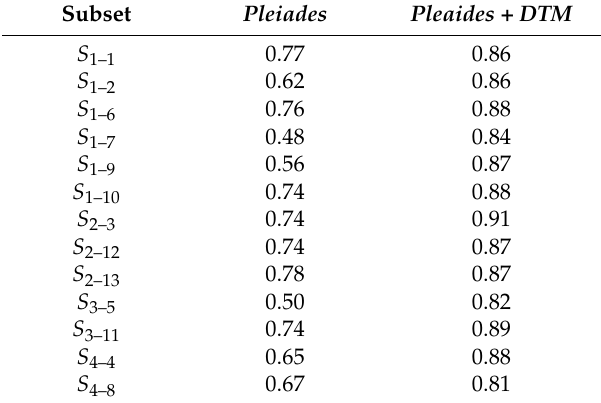
Figure 5. An example of inundated land that was: incorrectly classified by Pleiades ( a , c ); and classified successfully by Pleiades + DTM ( b , d ). Pleiades 0.5 m ( e ); and elevation data ( f ) are presented to interpret the yellow points. Table 3. The accuracy comparison between Pleiades and Pleiades + DTM using FCM classification with thresholding ( c = 2 , m = 1.6, t = 0.5). The inclusion of DTM in classifications clearly improved the classification results. S a − b : the name of subsets, a is the group number ( a = 1,..,4 ) and b is the subset number ( b = 1, . . . 13 ) . Subset Pleiades Pleaides +